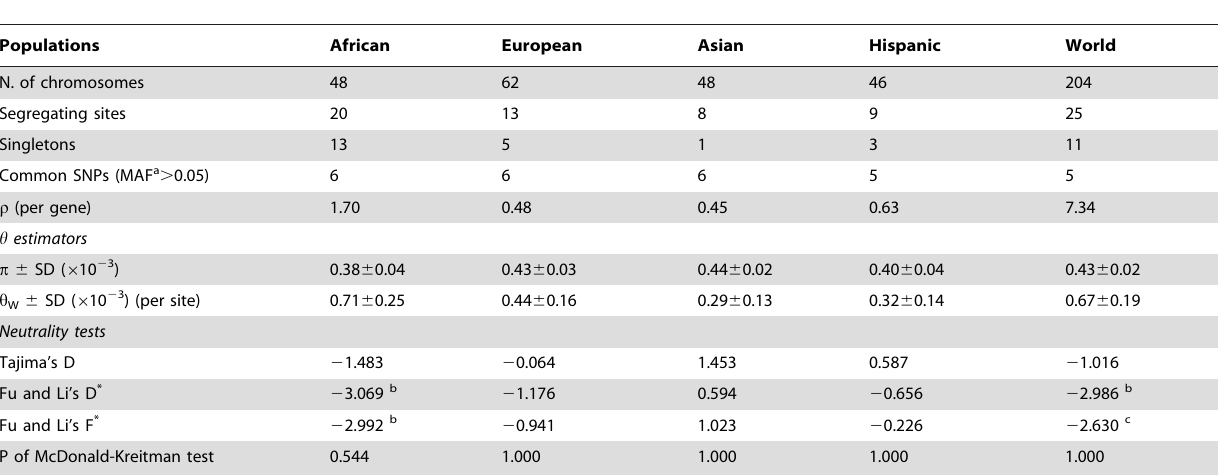
Table 1. Summary of intra-population diversity indexes and tests of neutrality based on re-sequencing analysis of the four SNP500Cancer populations.